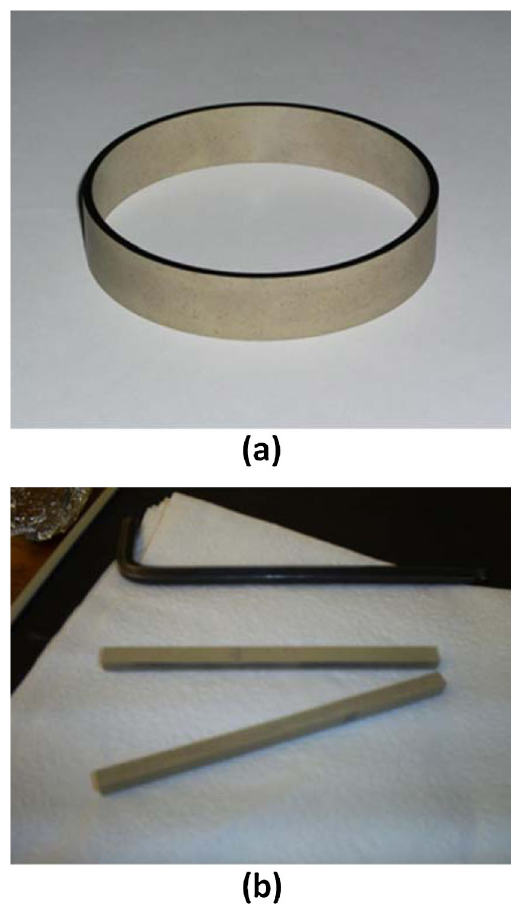
FIG. 2. (a) FE ceramic ring (cid:1)106 (cid:3) 2 : 8 (cid:3) 22 mm . Typically the top and bottom of the ring are fully coated with a thin, gold- based metallization layer (in a process proprietary to Ceramic,